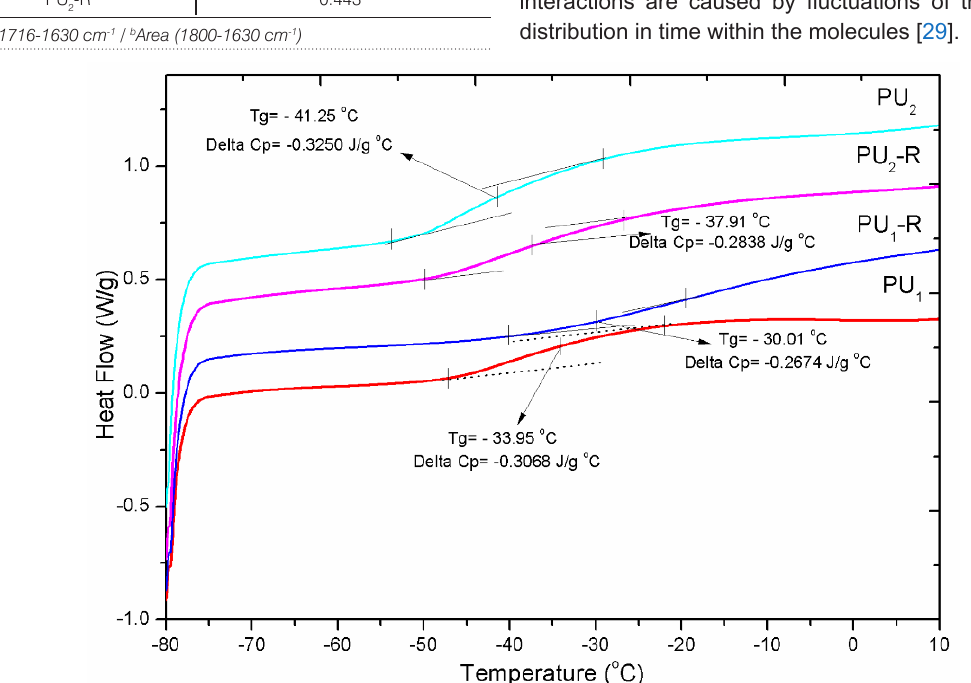
Figure 2. DSC curves of PU